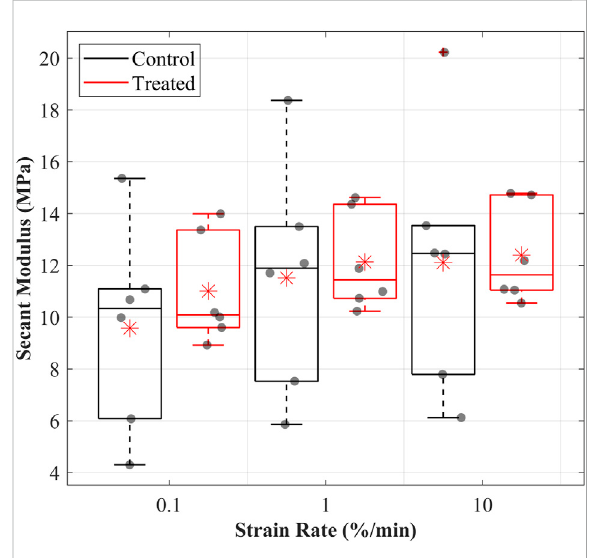
FIGURE 2 Secant modulus values were determined for the cranial cruciate ligaments (CCLs) in the control (black line) group, where proteoglycans were not depleted, and the treated (red line) group, where proteoglycans were depleted, at varying strain rates. The box plot shows individual specimen values (grey dots) and means (red asterisk) during loading at 0.1%/min, 1%/min, and 10%/ min strain rates. The outliers are indicated with a red plus